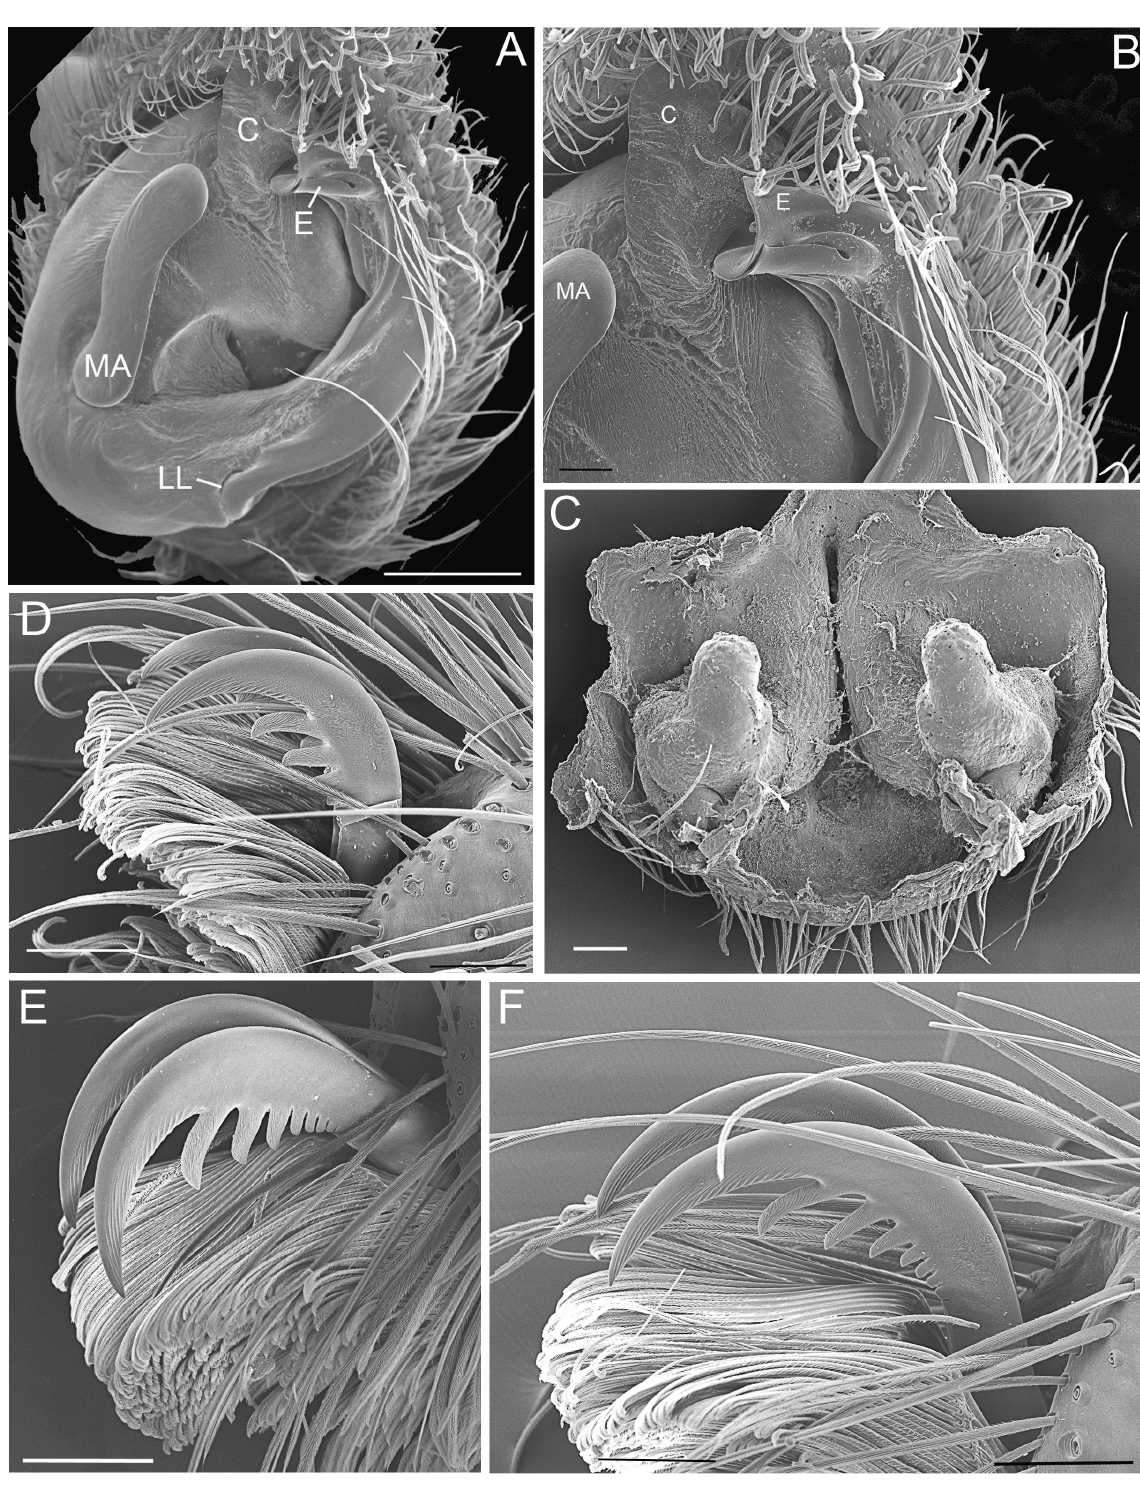
Fig. 1. Afroneutria velox (Blackwall, 1865) comb. nov.. — A–B . Male palp, ventral view. — C–F . ♀. C . Epigynum, dorsal view. D–F . Tarsus, lateral view. D . Leg III. E . Leg I. F . Leg IV. Scale bars = 200 µ